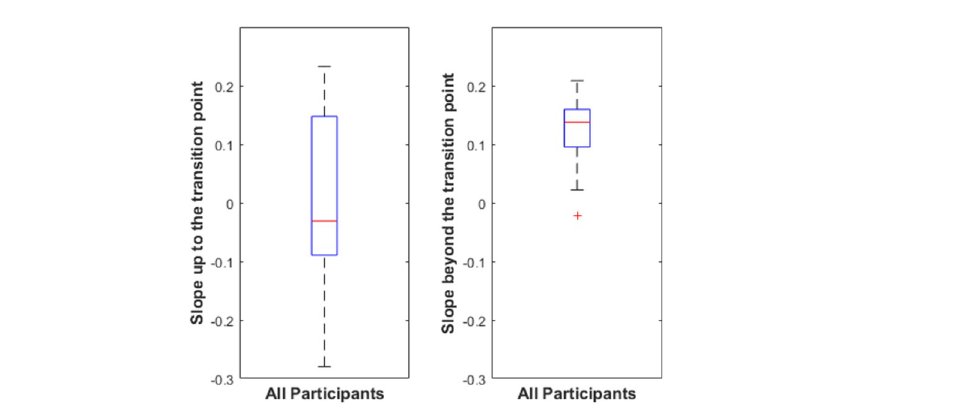
Fig 9. Boxplot of participants’ performance slopes up to and beyond the transition point. The box shows the interquartile range of slopes for individual participants. The red line shows the sample median. The red line shows the sample median. The whiskers extend to the most extreme datapoint within 1.5 times the length of the interquartile range from the top or bottom edge of the box (covering 99.3% of the data if they are normally distributed). Outliers are data points beyond the whisker and are plotted as red +’s.